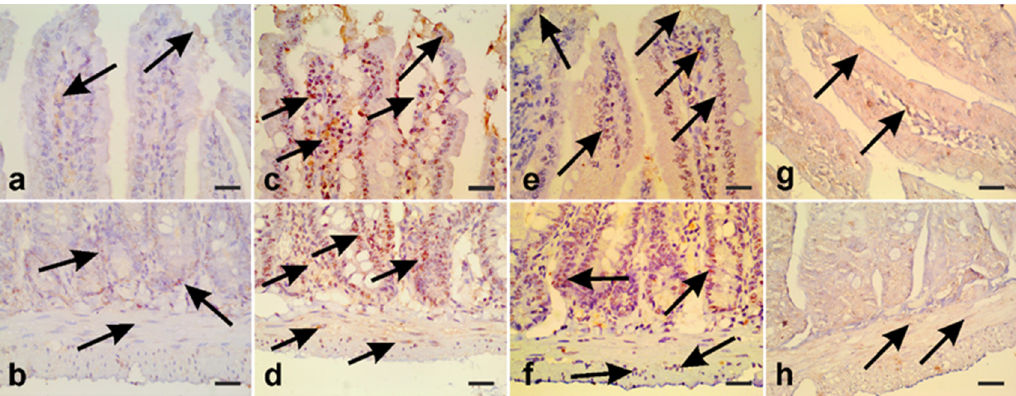
Figure 12. Treatment with A. annua inhibited apoptosis of intestinal cells that is induced by G. lamblia infection. ( a , b ) Representative intestinal tissue sections of small intestine, from uninfected hamsters, showing weak caspase-3 signals (arrows). ( c ) Representative intestinal tissue, from infected animals, showing strong caspase-3 signals in entero- cytes and lamina propria cells (arrows) and in ( d ) crypts and muscularis externa (arrows). Representative intestinal tissue, from infected animals treated with metronidazole, showing lower levels of caspase-3 in the enterocytes and villi core cells ( e ) (arrows) and in crypt cells and muscularis externa ( f ). ( g , h ) showing a very low level of caspase-3 in intestinal tissue of infected animals that are treated with A. annua . Scale bar = 30 µm.